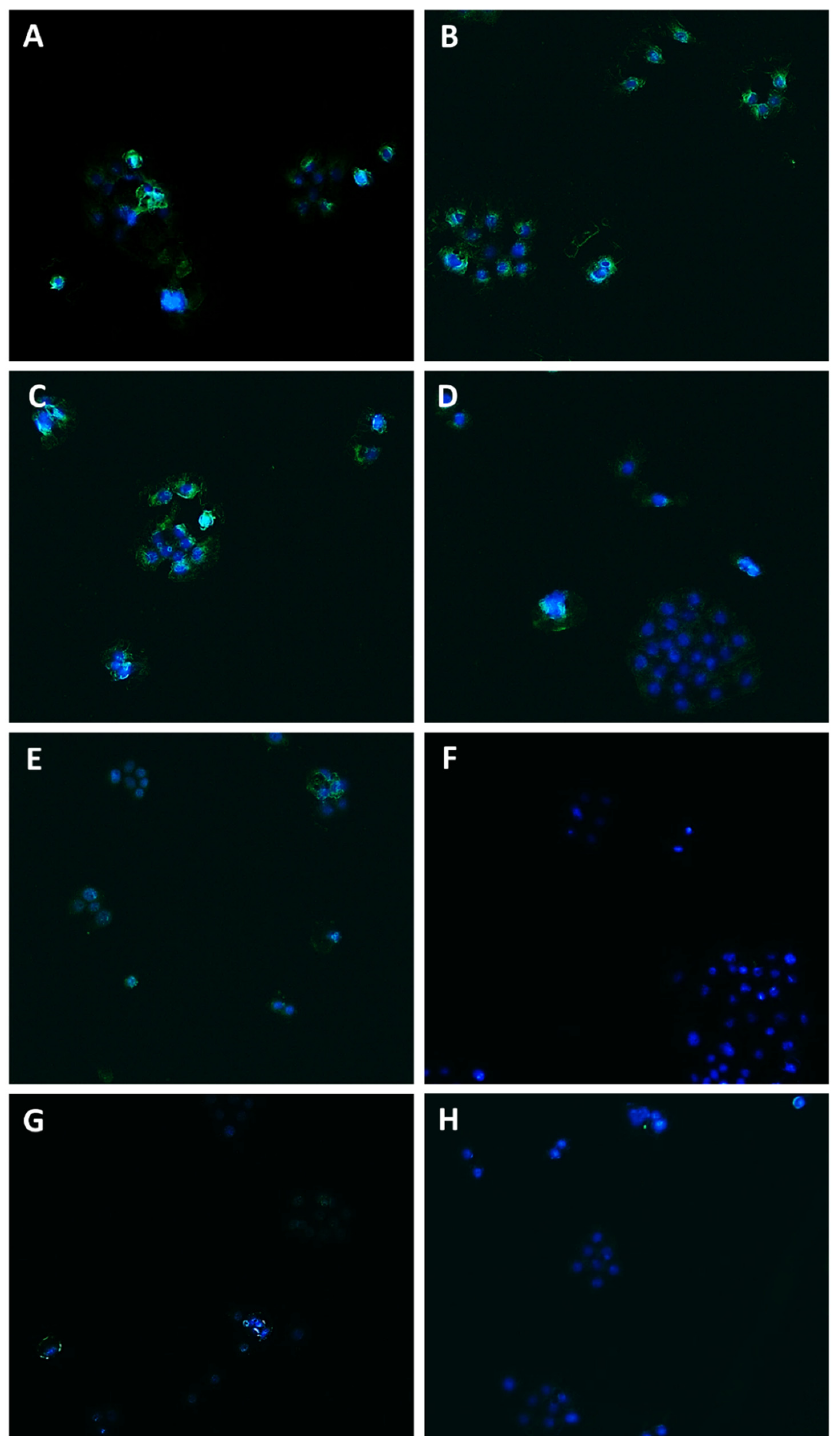
Figure 9. Modulation of Pgp transporter expression in Bx-PC3 cells detected after 4 h exposure and 72 h recovery time. Representative images obtained at immunofluorescence analysis. Original magnification: 10×. ( A ) Control; ( B ) sorafenib 10 µg/mL; ( C ) verapamil 1 µg/mL; ( D ) verapamil 1 µg/mL + sorafenib 10 µg/mL; ( E ) β -caryophyllene 10 µg/mL; ( F ) β -caryophyllene 10 µg/mL + sorafenib 10 µg/mL; ( G ) β -caryophyllene oxide 10 µg/mL; ( H ) β -caryophyllene oxide 10 µg/mL + sorafenib 10 µg/mL.